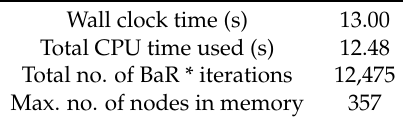
Table 6. The solution statistics for (10), using BARON with range